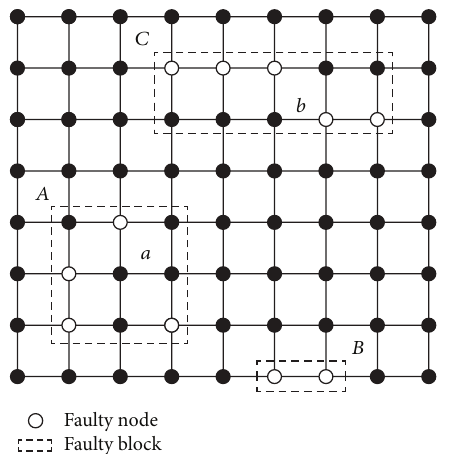
Figure 1: An example of disconnected rectangular blocks. Note that nonfaulty nodes, such as nodes 𝑎 and 𝑏 , in a block will never be used in routing any